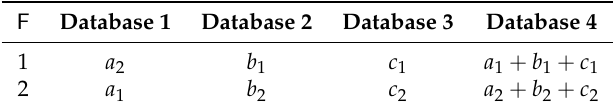
Table 5. Answers for W 1 .